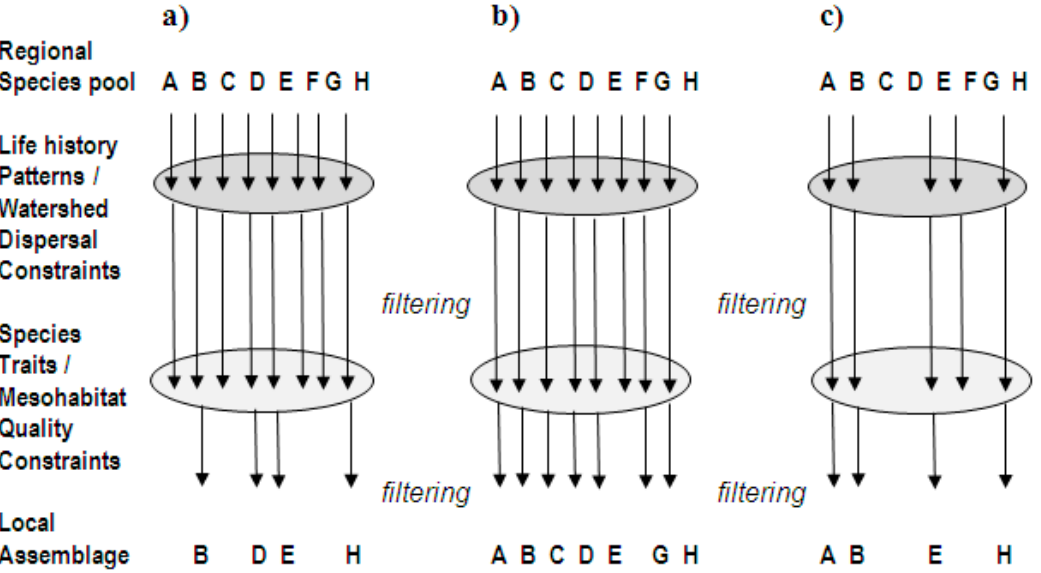
Figure 2. Conceptual basis for a gap analysis for a reach ‐ scale habitat restoration using hypothetical outcomes for: ( a ) no watershed ‐ scale stressors or dispersal constraints and mesohabitat degradation; ( b ) no watershed ‐ scale stressors or dispersal constraints and mesohabitat restoration; and ( c ) watershed ‐ scale stressors and mesohabitat restoration (adapted from Lake et al. (2007) [33]; Poff (1997) [114]; and Belya and Lancaster (1999)